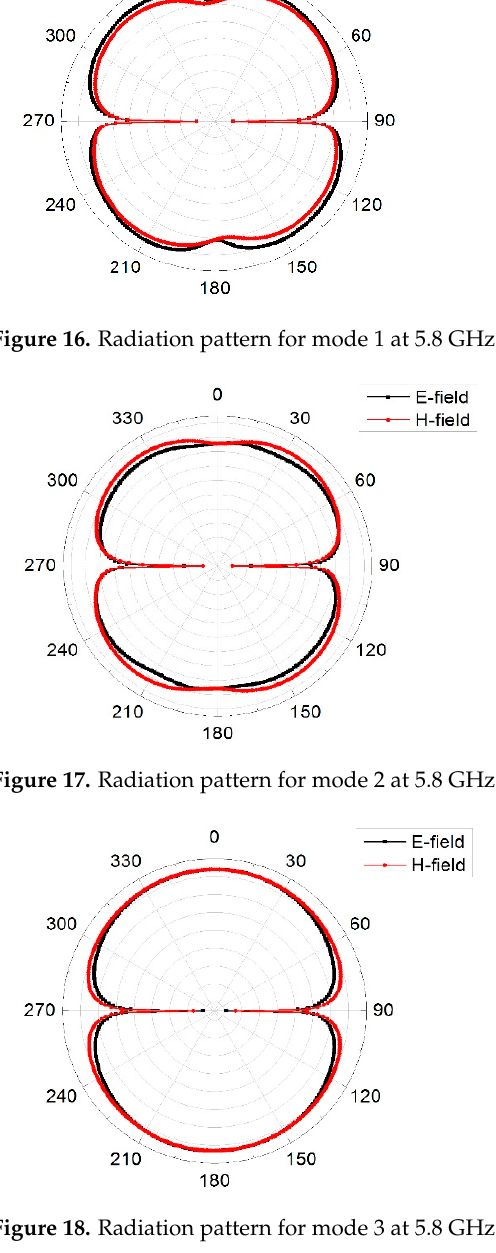
Figure 18. Radiation pattern for mode 3 at 5.8 GHz.